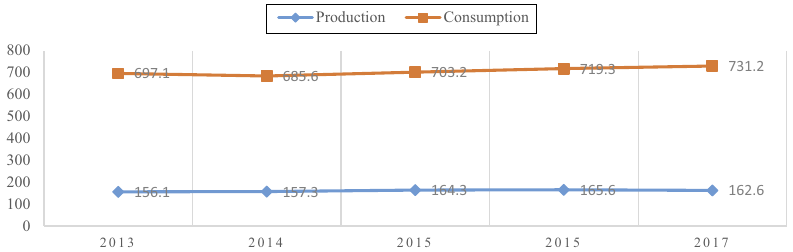
Figure 3. European oil